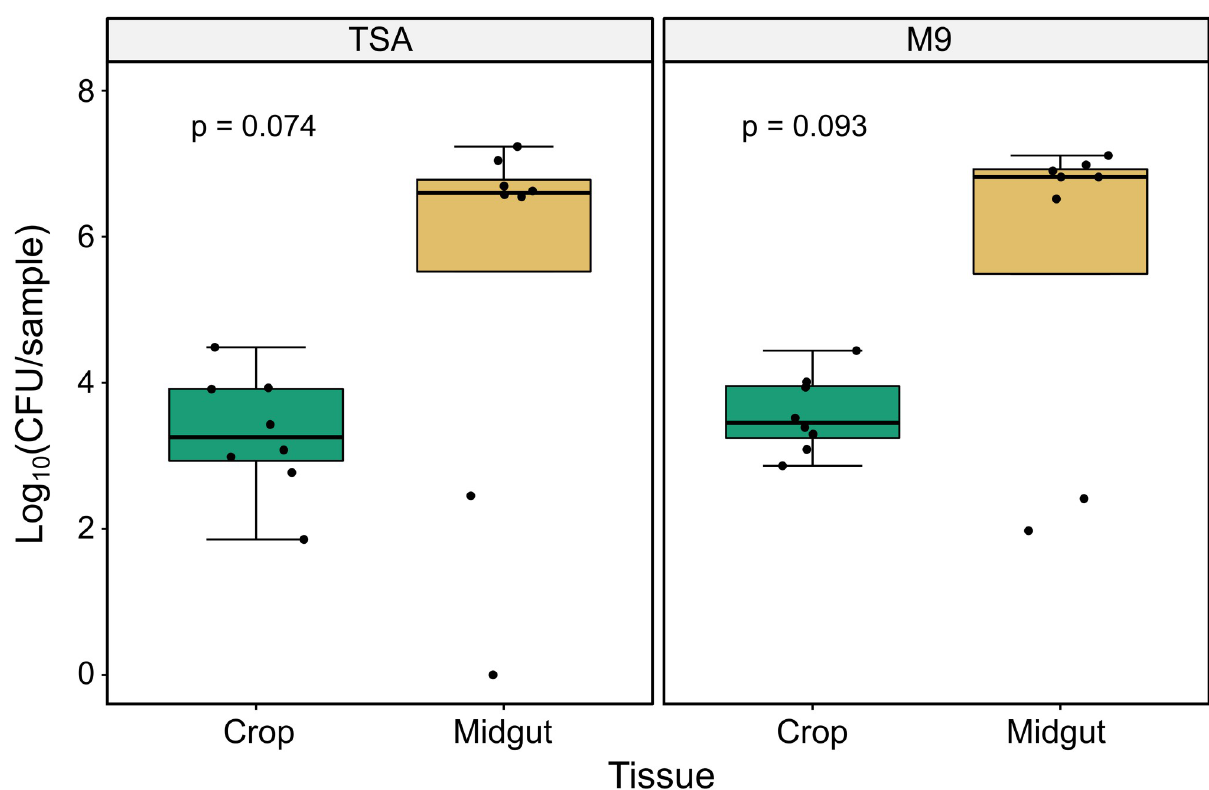
Fig 2. Bacterial load in crops and midguts of adult female Ae . aegypti . Individual crops and midguts from eight adult females were homogenized and cultured on TSA (left panel) and M9 (right panel) media. Variance was significantly different between tissues for both media types (TSA: F = 5.521, p = 0.034; M9: F = 11.554, p = 0.004) as measured by Levene’s test for equal variances. Tissue type was not a significant predictor of bacterial load on either media (TSA: p = 0.074; M9: p = 0.093) as measured by Kruskal-Wallis test.